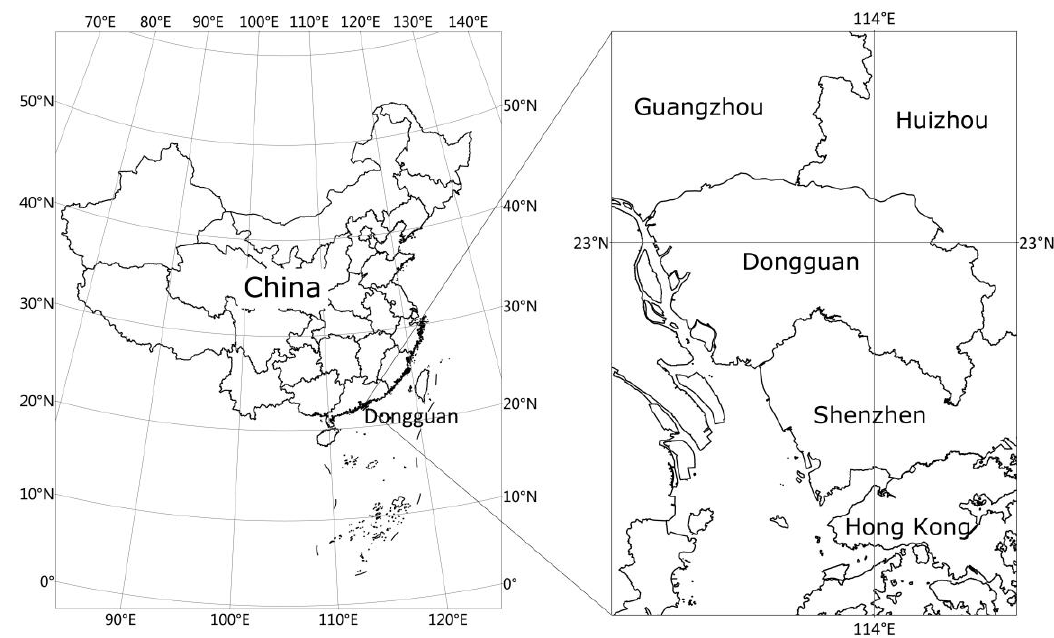
Figure 1. Location of Dongguan.